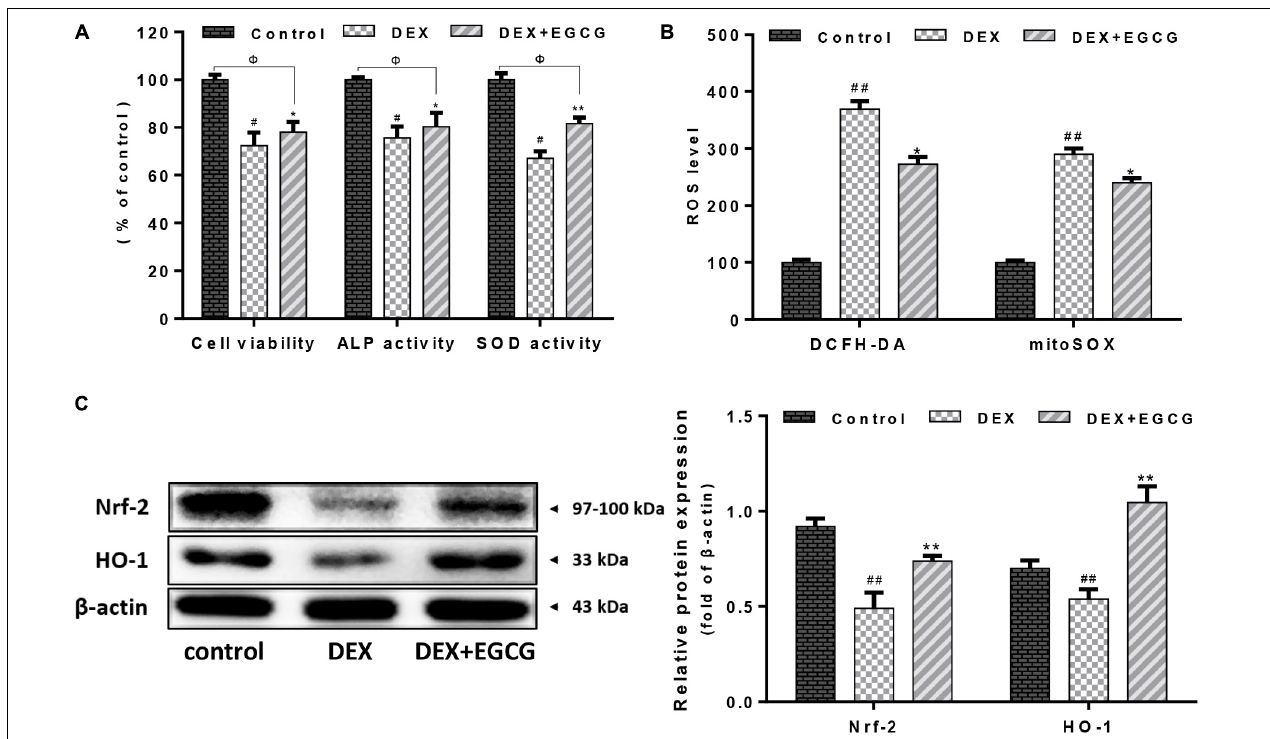
FIGURE 1 | Effect of EGCG on DEX-induced osteoblast cellular dysfunction. (A) EGCG improved cell viability, increased ALP activity, and recovered SOD expression in primary osteoblasts treated with DEX. (B) EGCG reversed cellular and mitochondrial oxidative stress according to cytometry of DCFH-DA and mitoSOX staining. (C) Expression of Nrf2 and downstream transcriptional factor HO-1 during EGCG protection under high-dose DEX treatment. Protein levels were statistically evaluated in columns. Measurements were in triplicate and data are presented as the mean ± SD . ## P < 0.01, # P < 0.05 vs. control; ∗∗ P < 0.01, ∗ P < 0.05 vs. DEX; and (cid:56) P < 0.05 DEX+EGCG vs.